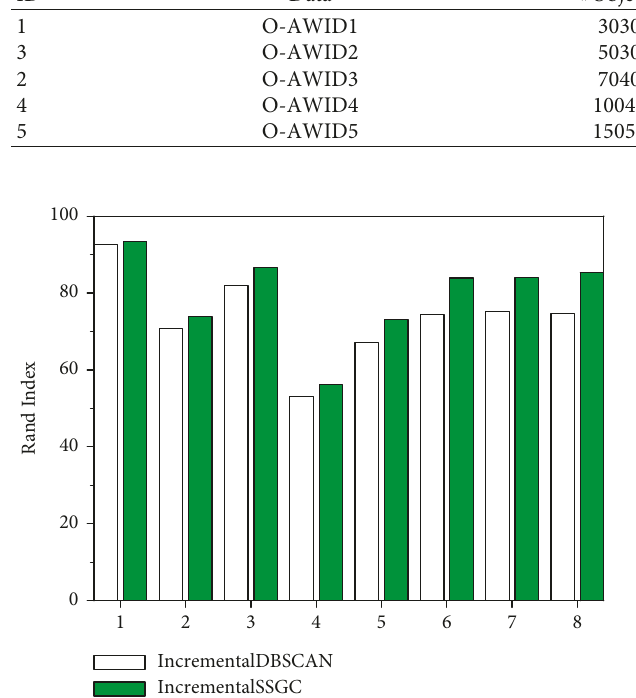
Figure 4: Clustering results obtained by IncrementalDBSCAN and IncrementalSSGC for 8 data set of Table 1,